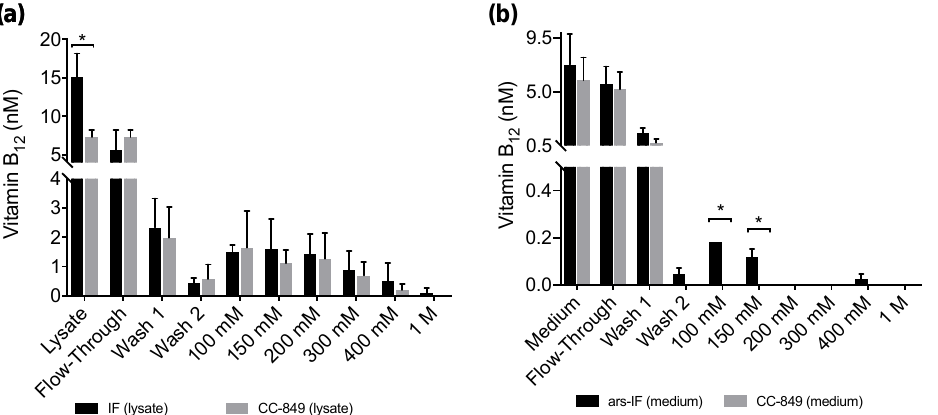
Figure 5. Vitamin B 12 content of protein fractions purified from IF and ars-IF strains grown with 20 µ g · L − 1 supplemented TAP medium determined using a plaque assay of Salmonella enterica ( metE – cbiB – ). Fractions were eluted with increasing concentrations of NaCl (100 mM to 1 M). Data show average values, error bars: standard error ( n = 3). Statistically significant differences between the control and the respective strain for each fraction are indicated with an asterisk (Student’s t -test, p < 0.05). ( a ) B 12 amounts detected in fractions of 1 L cellular lysates from IF and CC-849 strains. ( b ) B 12 amounts detected in protein fractions purified from 1 L medium of ars-IF or CC-849